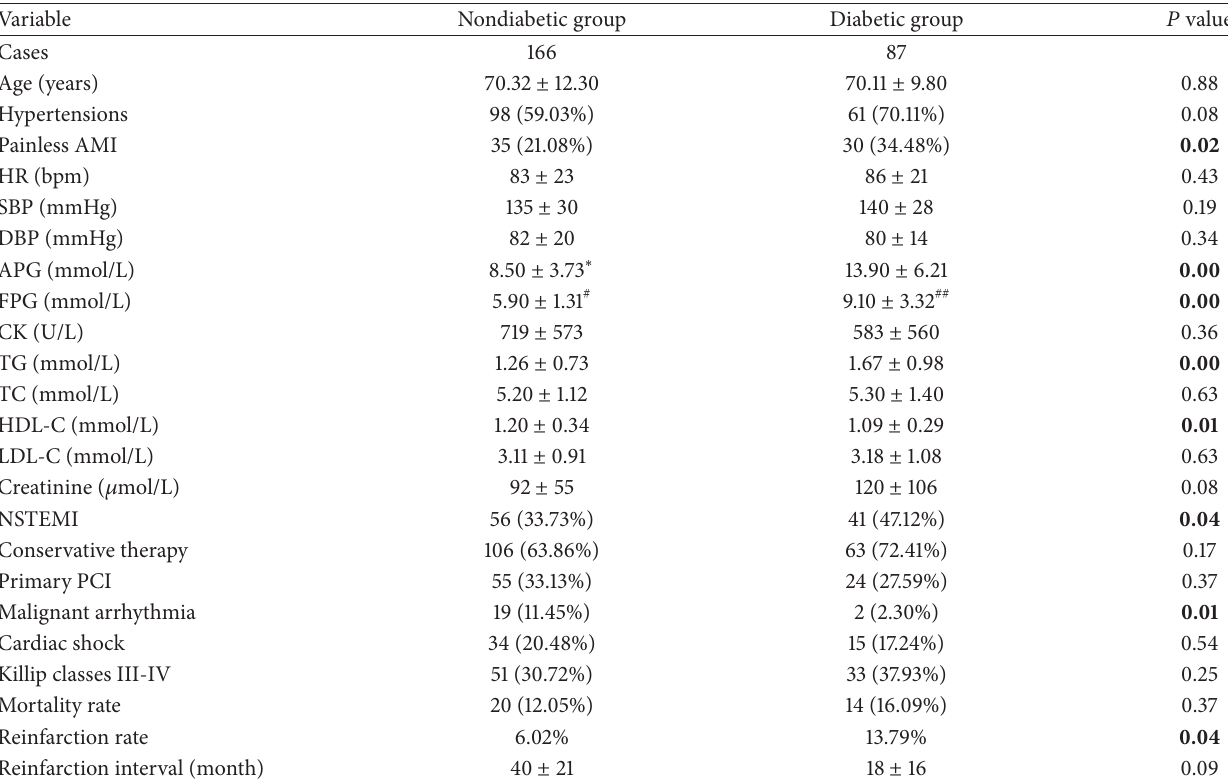
Table 1: Baseline characteristics of patients with and without diabetes mellitus.